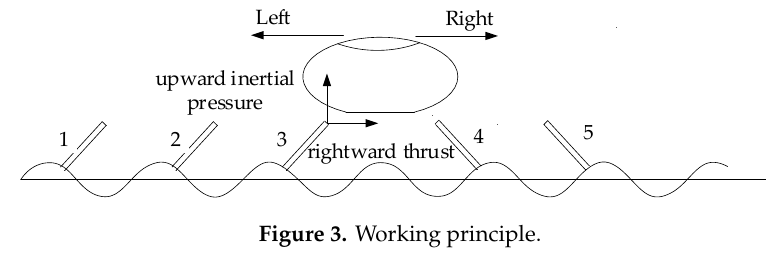
Figure 3. Working principle. Figure 3. Working